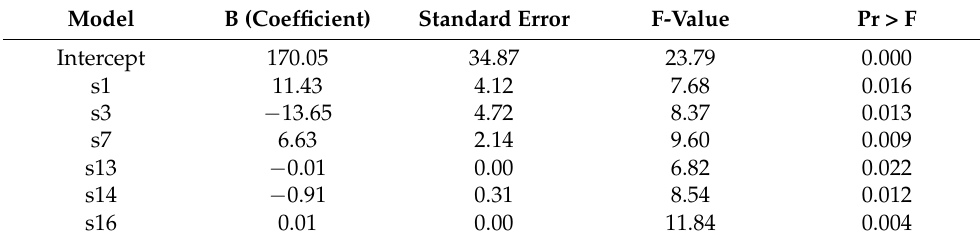
Table 7. Multiple linear regression analysis of meteorological factors and total starch content in grains. Model